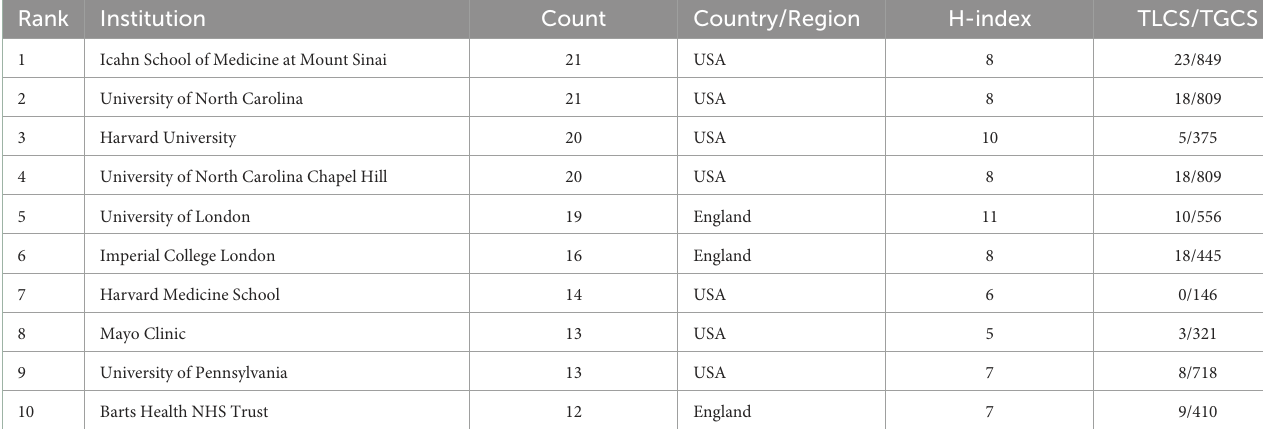
TABLE 2 The top 10 activist